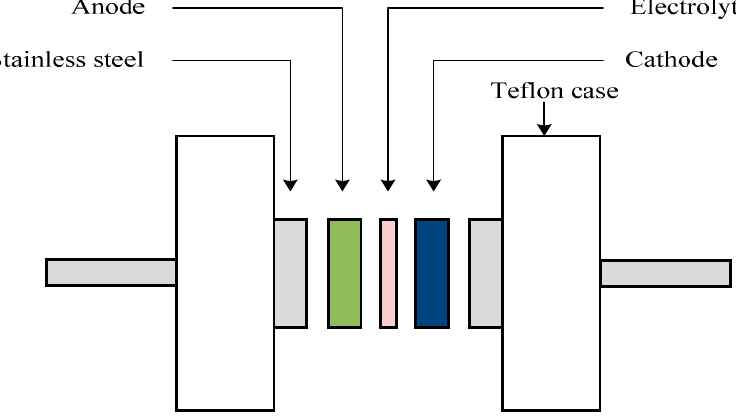
Figure 18. Diagram of the EDLC cell for CV and galvanostatic charge-discharge measurement.